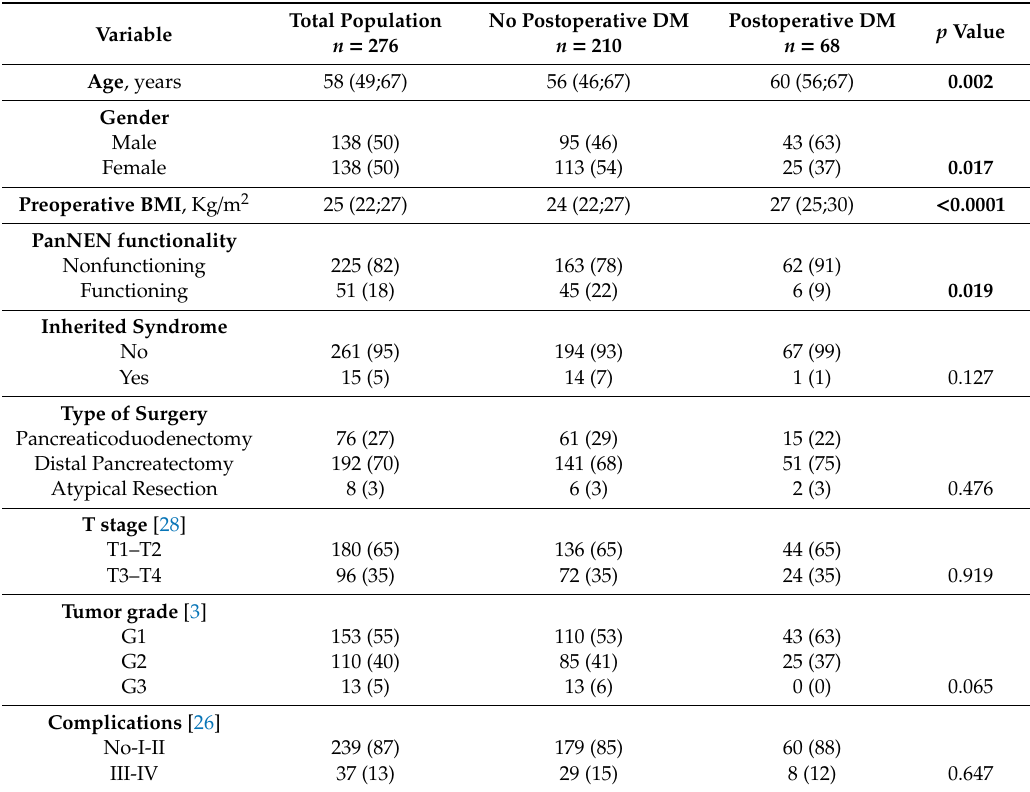
Table 2. Comparison of demographic, clinical and pathological characteristics between patients submitted to surgery for pancreatic neuroendocrine neoplasms (PanNEN) who developed postoperative diabetes mellitus (DM) ( n = 68) and those who did not ( n = 208).